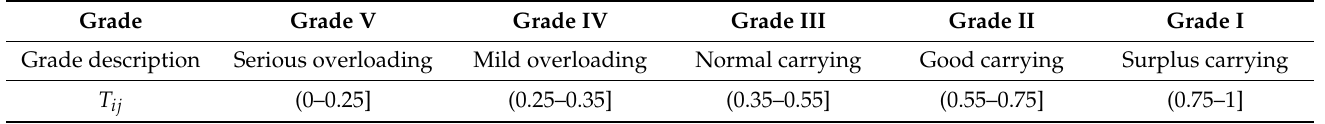
Table 2. Grading standards of water resource carrying capacity for